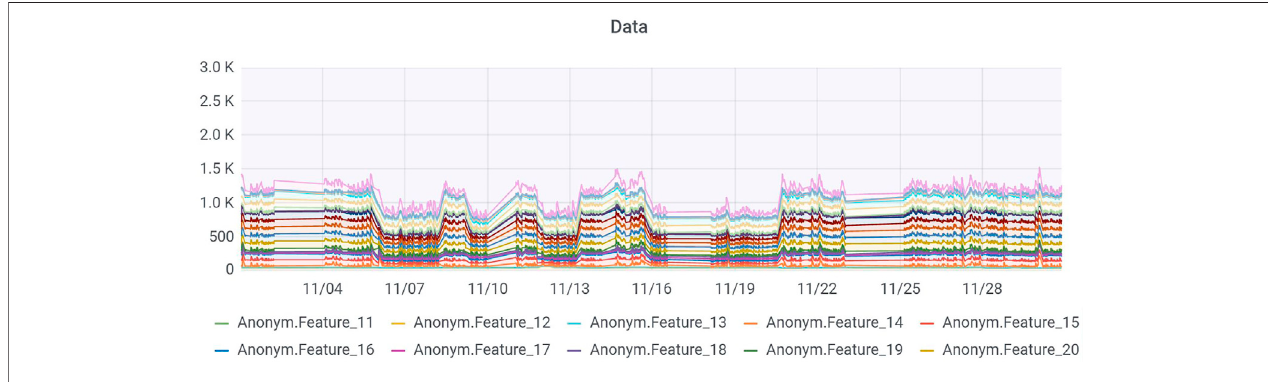
FIGURE 4 | Visualization of recorded process parameters in Grafana using a stacked bar plot. The features of the mock-up scenario resemble temperature measurements in different temperature zones recorded over a month. Users are able to identify measurement stops as well as correlated sensor data.